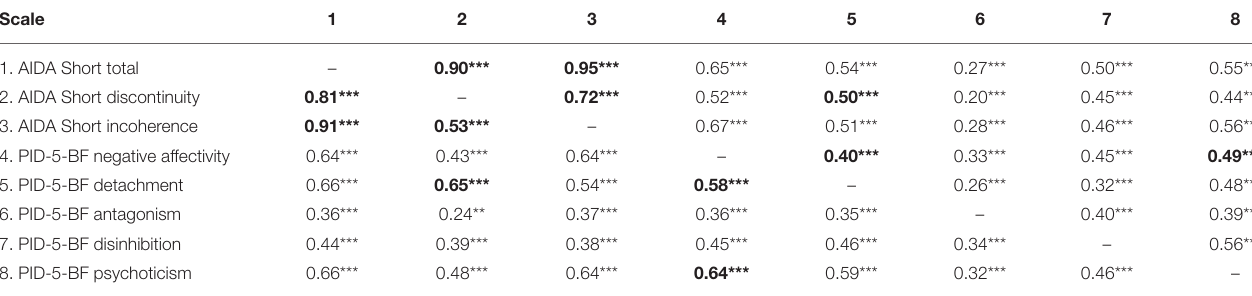
TABLE 2 | Intercorrelations between the AIDA Short and the PID-5-BF in the refugee (below the diagonal, n = 120) and the migrant sample (above the diagonal, n = 281).